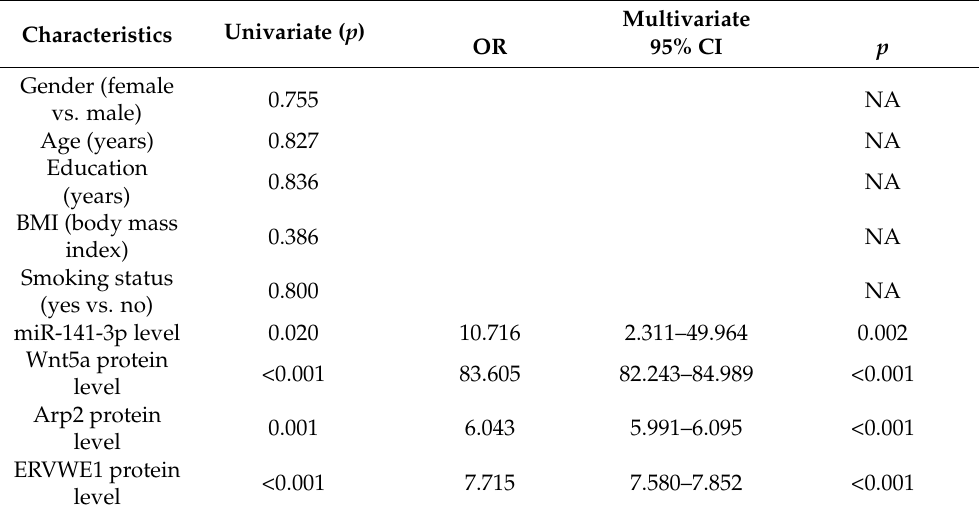
Table 1. Univariate and multivariate analysis of risk factors for